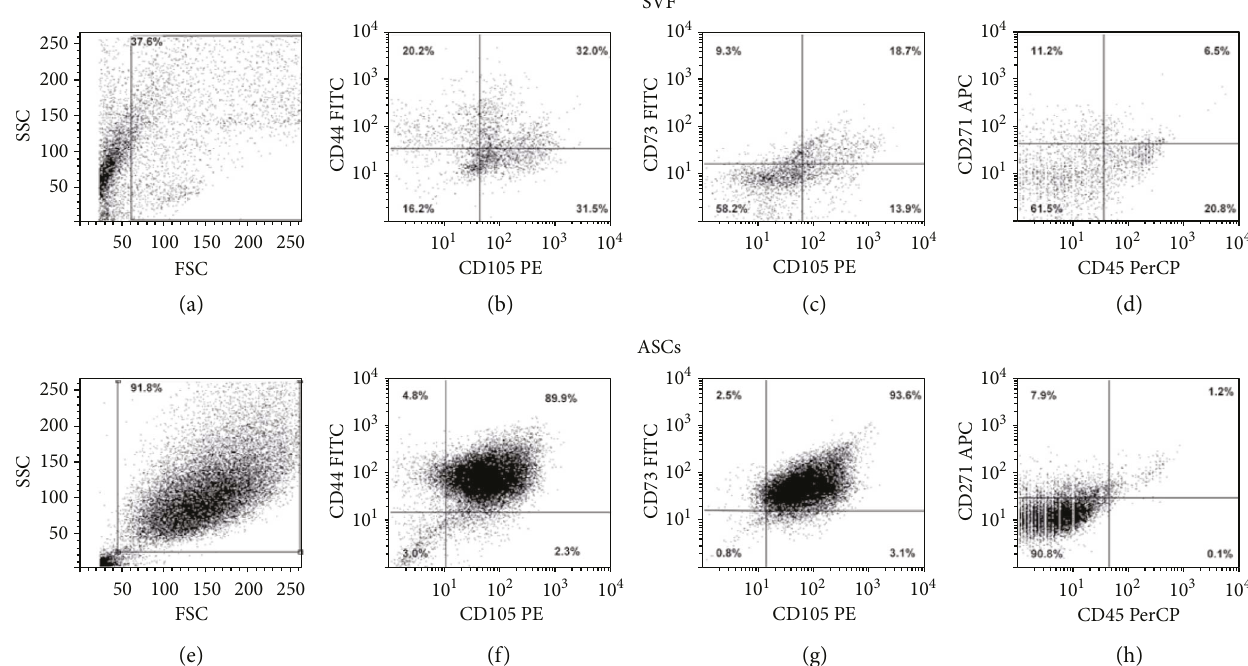
Figure 1: Flow cytometry analysis of mesenchymal cells in freshly isolated and cultured SVF. Dot plots show the morphology of SVF (a) and ASCs (e). SVF is a heterogeneous cell population, containing CD105-, CD44-, CD73-, and CD271-positive mesenchymal cells (b, c) and a small fraction of CD45-positive cells (d), due to the normal presence of leukocytes in SVF. After 15 days of culture, a large and enriched population of ASCs highly expresses mesenchymal markers (f, g), whereas it is completely negative for software (Bruker). A color contrast mask was used to allow a clear identi fi cation of newly formed mineralized tissue.